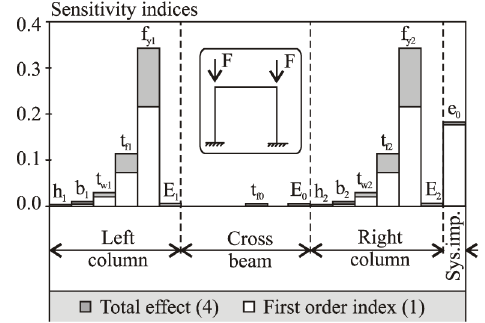
Fig. 8. Total sensitivity analysis – Frame 1, h = 3 m